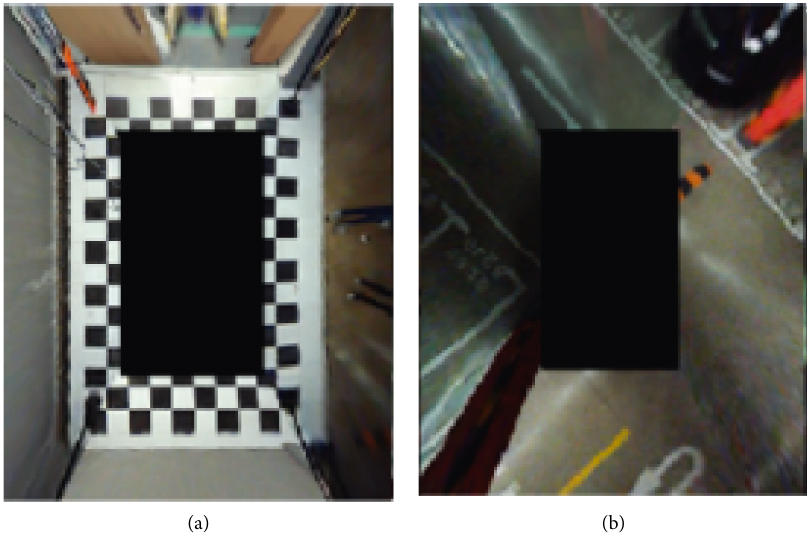
Figure 4: Synthesized picture. (a) Well-calibrated synthesized pictures. (b) Synthesized picture during